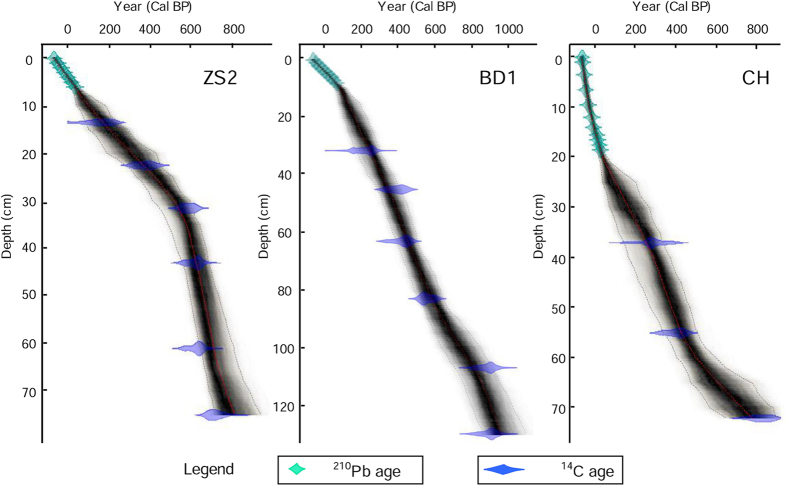
Bayesian age-depth models of the studied profiles ZS2, BD1 and CH by both 210Pb and 14C dates.